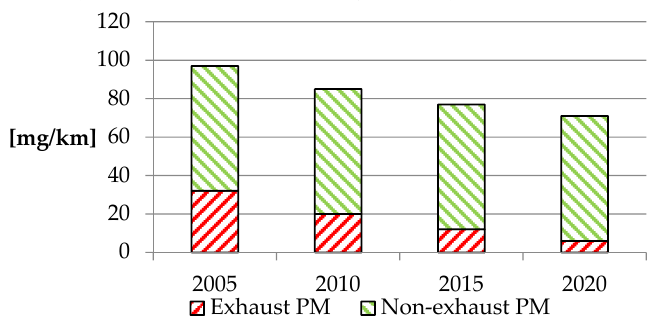
Figure 5. Forecasts for the emission factors of PM 10 , both exhaust and non-exhaust related, up to 2020 (based on [48]).